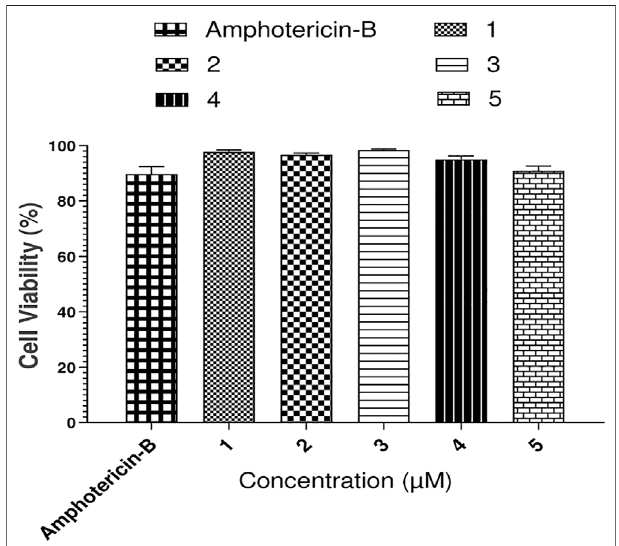
FIGURE 12 | Cytotoxicity results of compounds 1 – 5 against THP-1 monocytic cells.